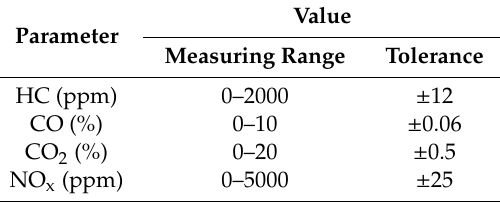
Table 5. The range of each exhaust